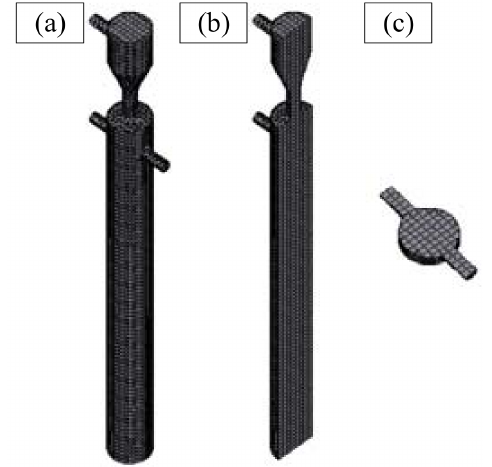
Figure 2. Grids: ( a ) Overall Grid; ( b ) Grid 1; ( c ) Grid